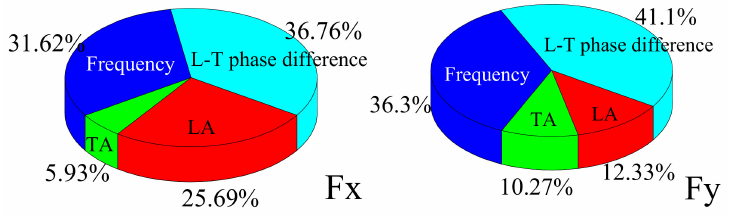
Figure 15. Relative sensitivity of ultrasonic parameters to cutting force.